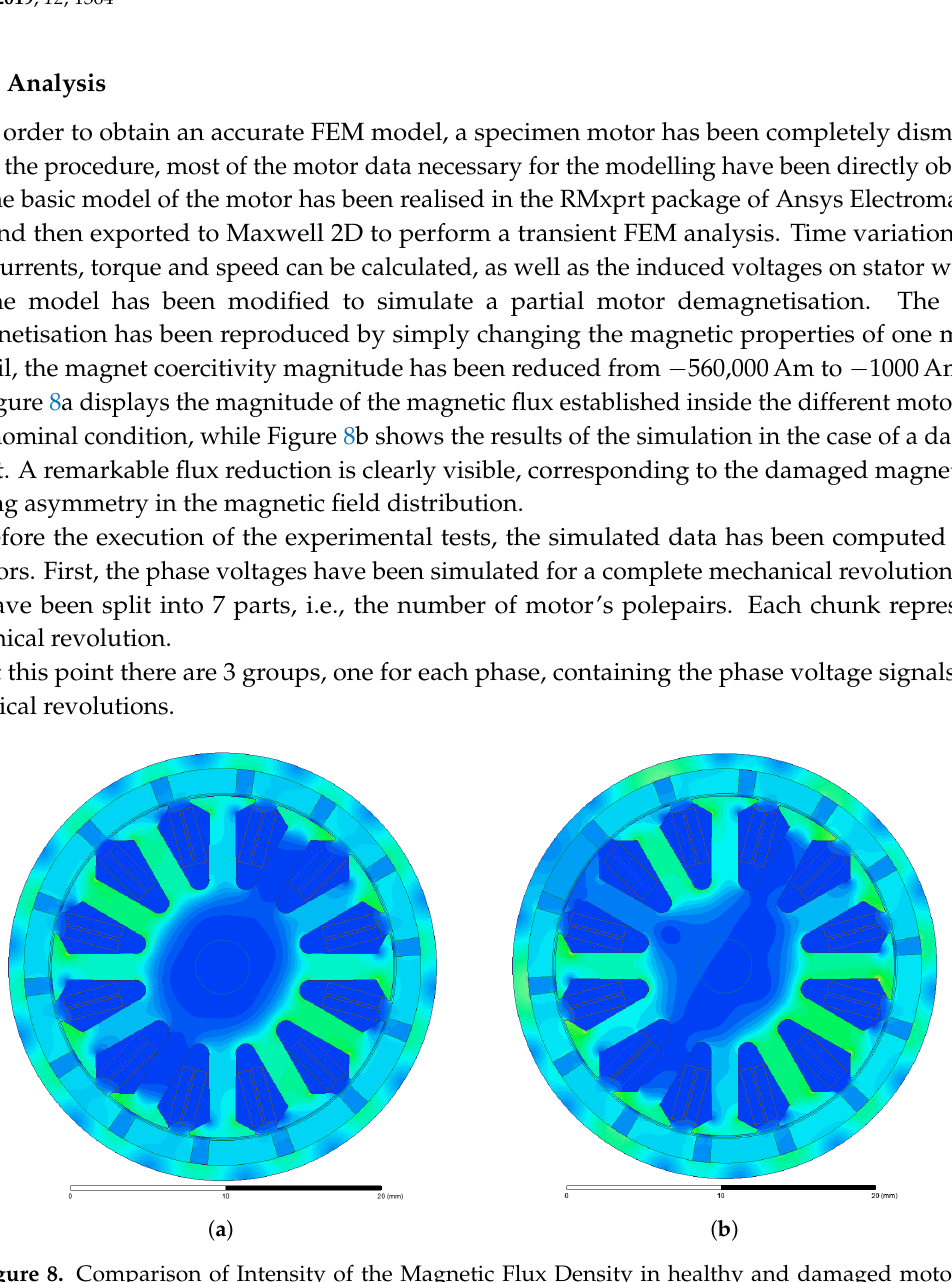
Figure 8. Comparison of Intensity of the Magnetic Flux Density in healthy and damaged motors. ( a ) Intensity of the Magnetic Flux Density in the healthy motor; ( b ) Intensity of the Magnetic Flux Density in the motor with a demagnetised